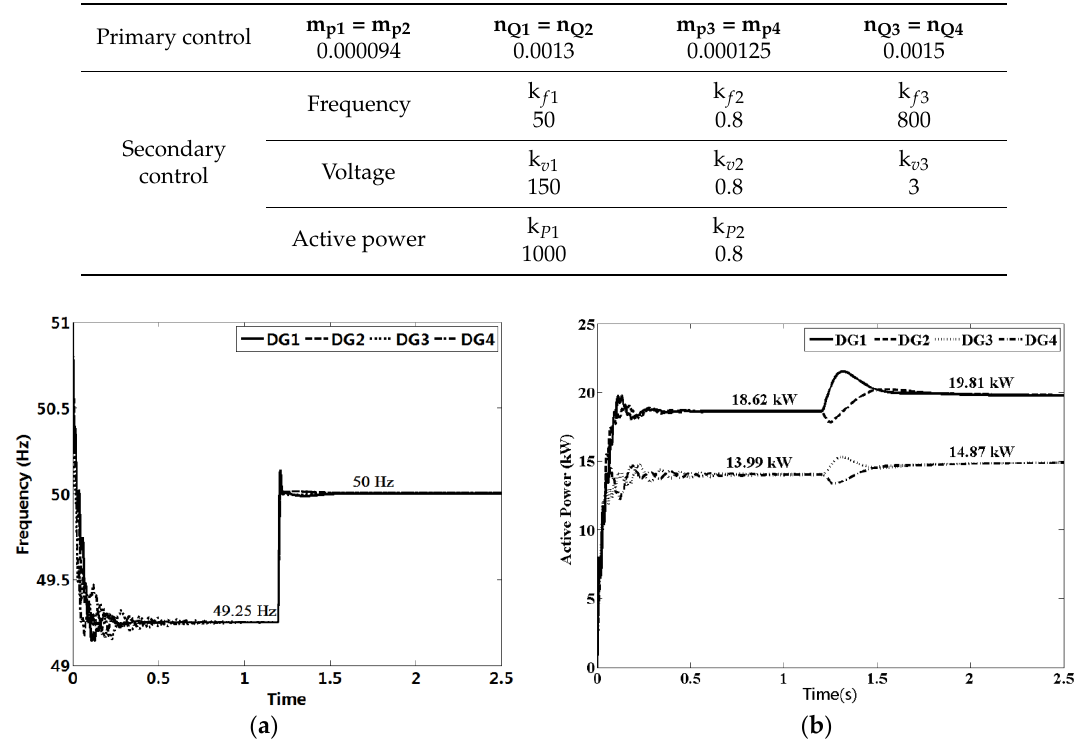
Figure 7. Simulation results of the secondary frequency control. ( a ) the islanded MG frequency and ( b ) the active power of DGs.